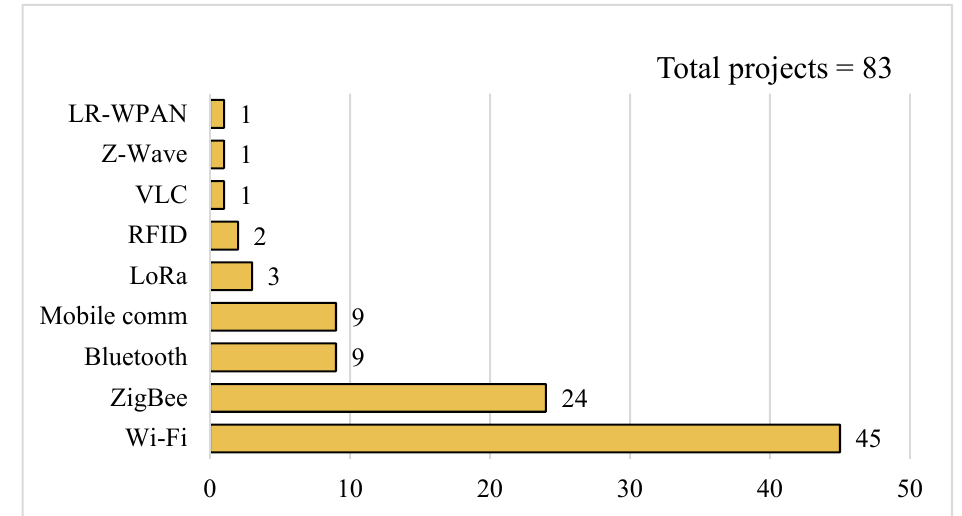
Figure 6. The use of communication technology in the projects.